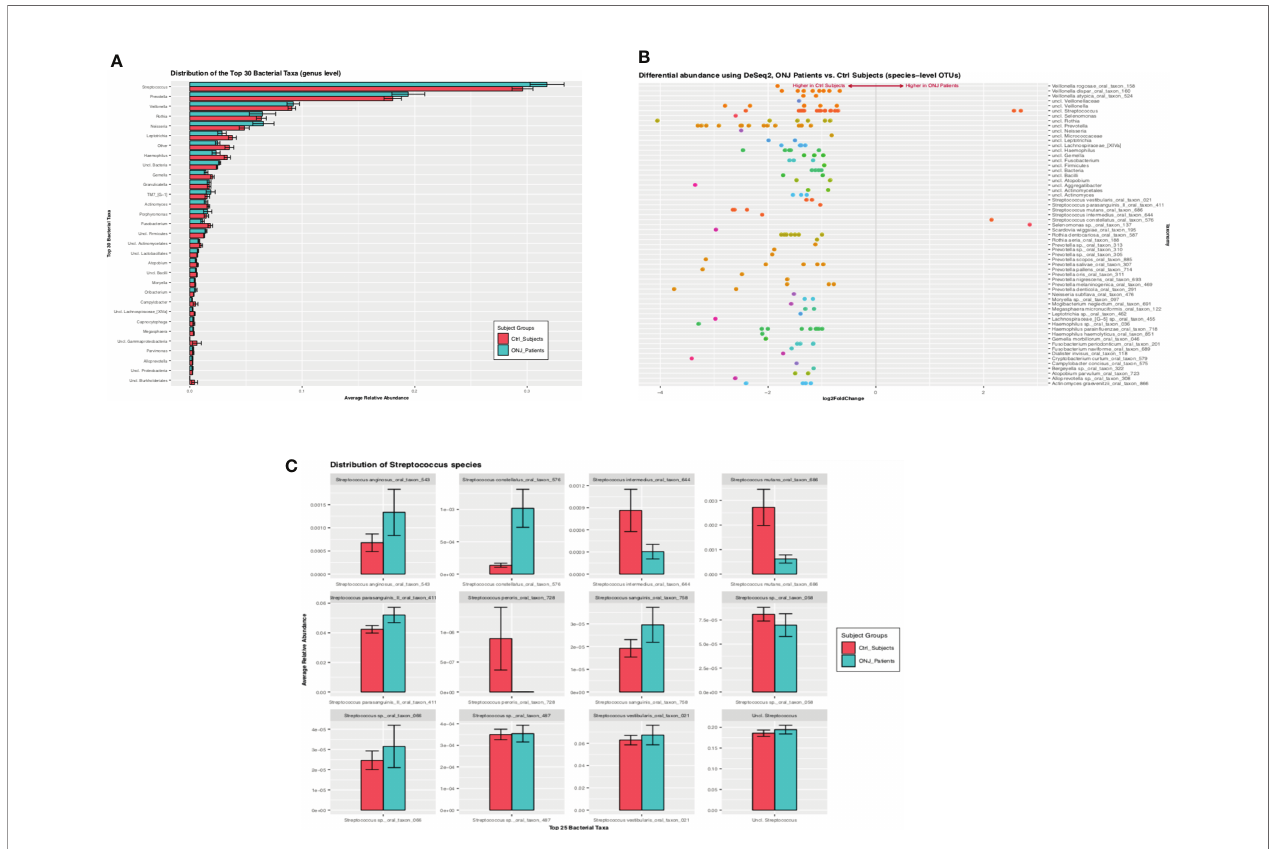
FIGURE 2 | (A) Bar graph showing the distribution of the 30 top bacterial taxa (assigned at the genus level) between BRONJ and controls. Relative abundance of three genera ( Streptococcus , Prevotella , and Veillonela ) is seen in both BRONJ and controls. (B) Differential Relative Abundance Analysis Using Deseq2. Pairwise comparison of the relative abundance of Operational Taxonomic Units (OTU) at species level; positive values of the Log2 fold change indicate higher relative abundance in BRONJ and negative values indicate higher relative abundance in control. (C) Distribution of Streptococcus species between Control (red) and BRONJ